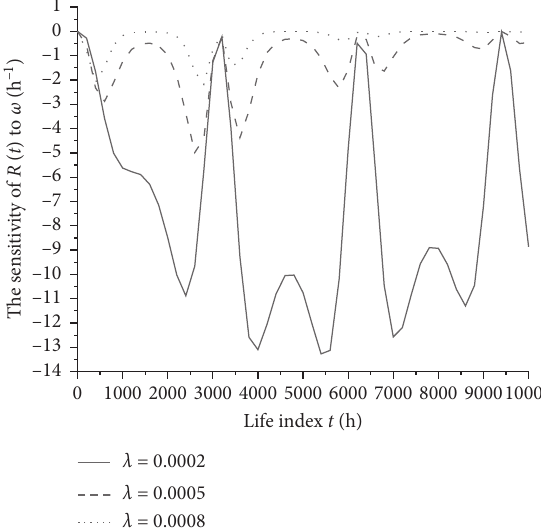
Figure 21: The sensitivity of h ( t ) to A ( λ � 0.0002/0.0005/0.0008).